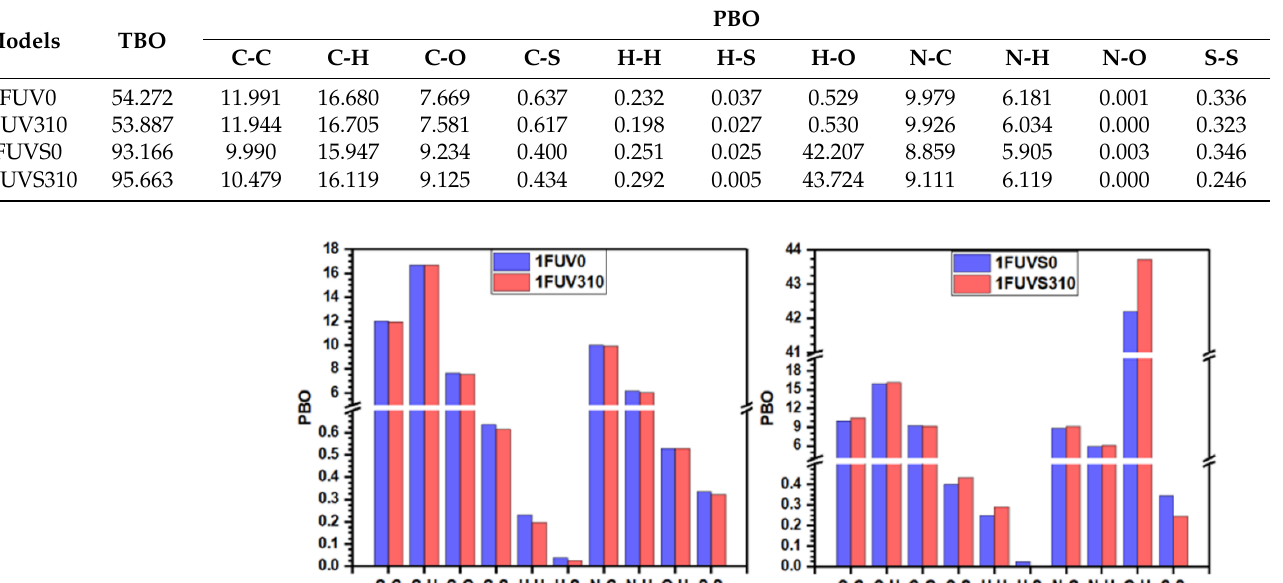
Table 1. Calculated TBO and PBO values for each bonded pair in simulated models.